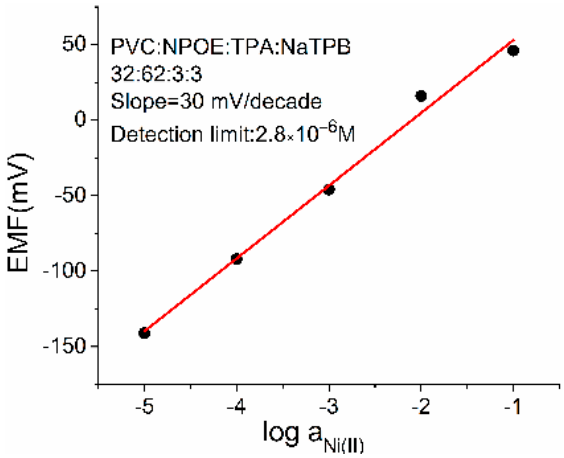
Figure 5. Potentiometric characteristics calibration curve for Ni 2+ selective sensor based on TPA.